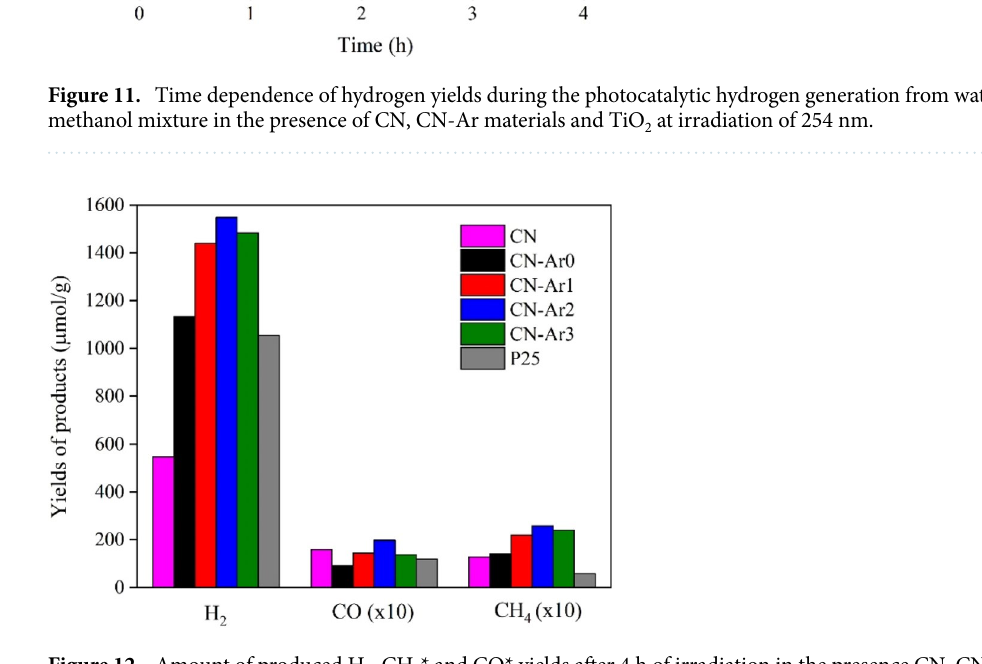
Figure 12. Amount of produced H 2 , CH 4 * and CO* yields after 4 h of irradiation in the presence CN, CN-Ar materials and TiO 2 (*multiplied by